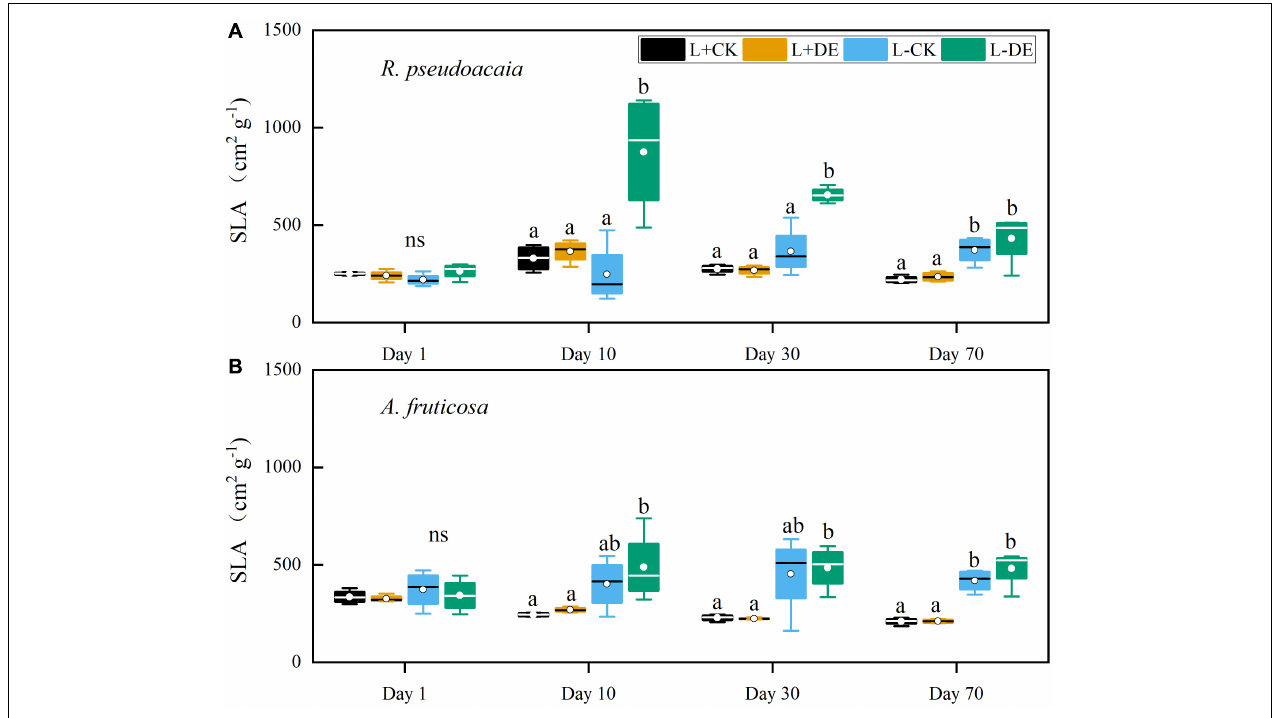
FIGURE 3 | Seedling specific leaf area (SLA) of R. pseudoacacia (A) and A. fruticosa (B) under different light and defoliation treatments. The values are shown as mean ± SE ( n = 4). Different letters indicate significant differences among different treatments at each sampling according to Duncan’s test ( p < 0.05). L + CK, high light condition with no defoliation; L + DE, high light condition treatment with defoliation; L − CK, low light condition with no defoliation; L − DE, low light condition with